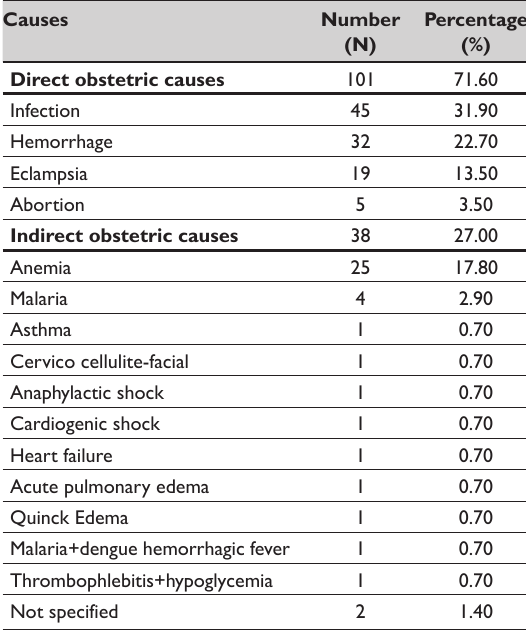
Table 4: Distribution of causes of maternal deaths in Dori Hospital, Burkina Faso, 2014-2016 (n=141)